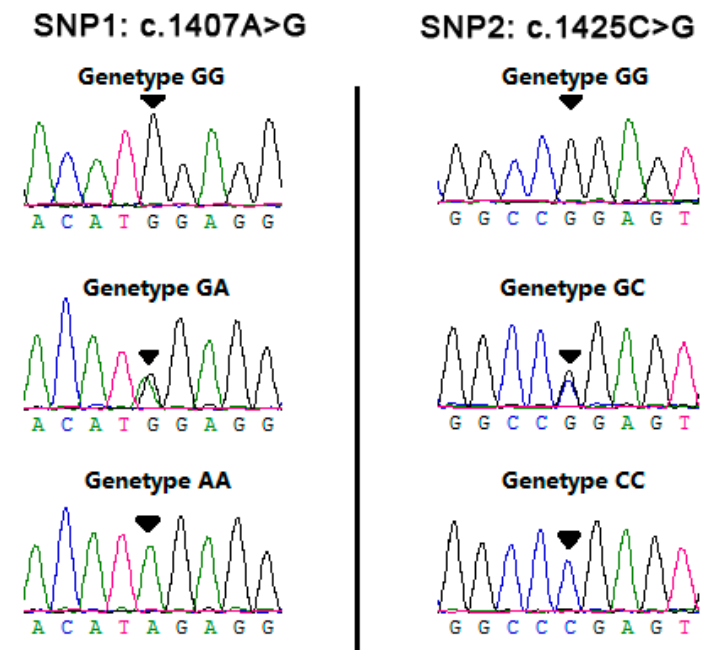
Figure 1. The sequencing results of the bovine RET gene and two SNPs are indicated by arrows.